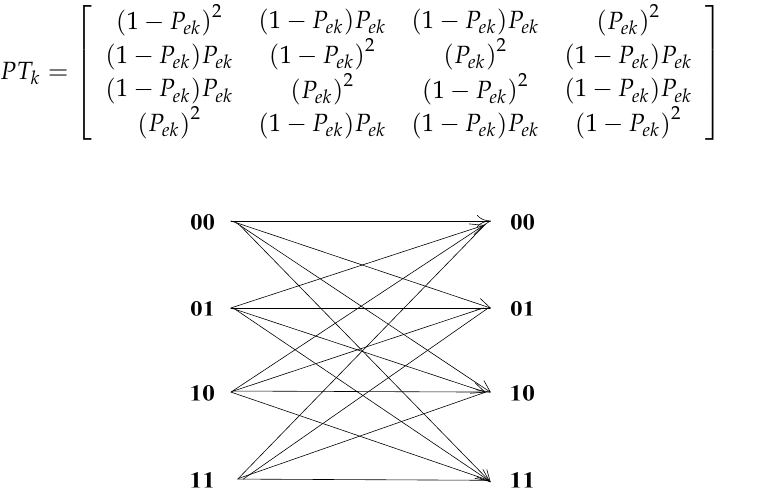
Figure 6. The station transition diagram in the 2-bit decision case.